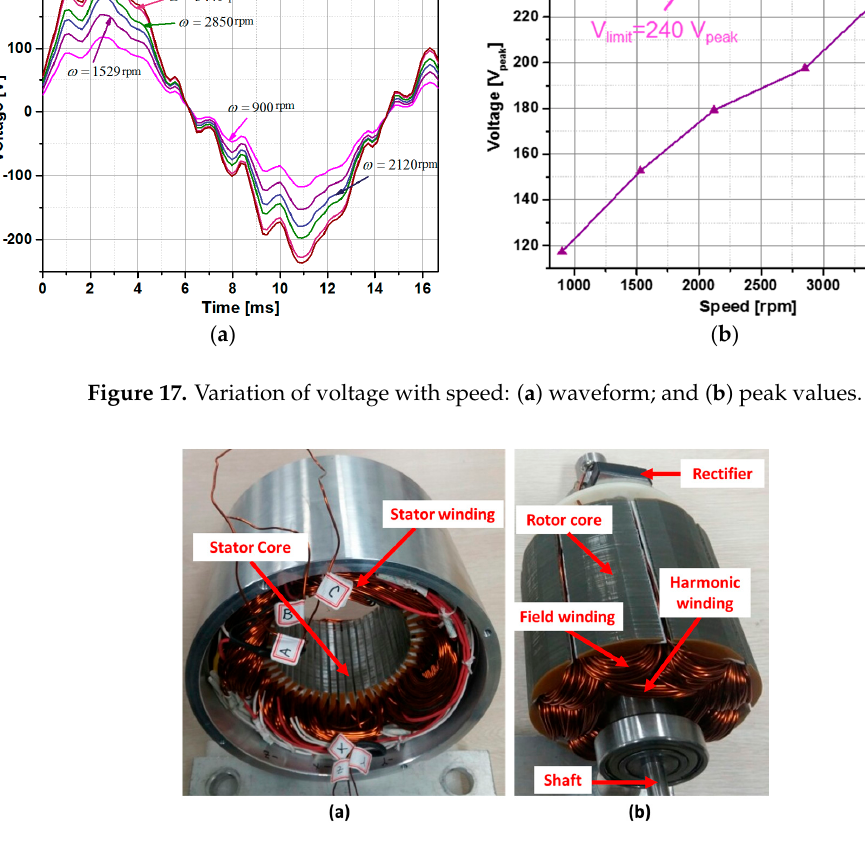
Figure 18. Three ‐ phase eight ‐ pole, 48 ‐ slot BL ‐ WRSM prototype: ( a ) stator; and ( b ) rotor.